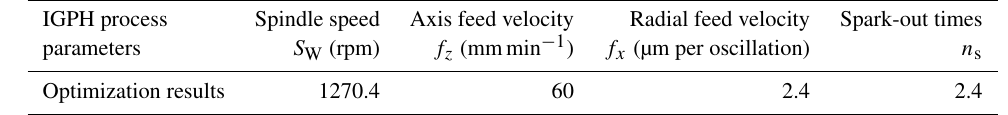
Table 5. The optimal combination of IGPH process parameters based on the AICSA method.